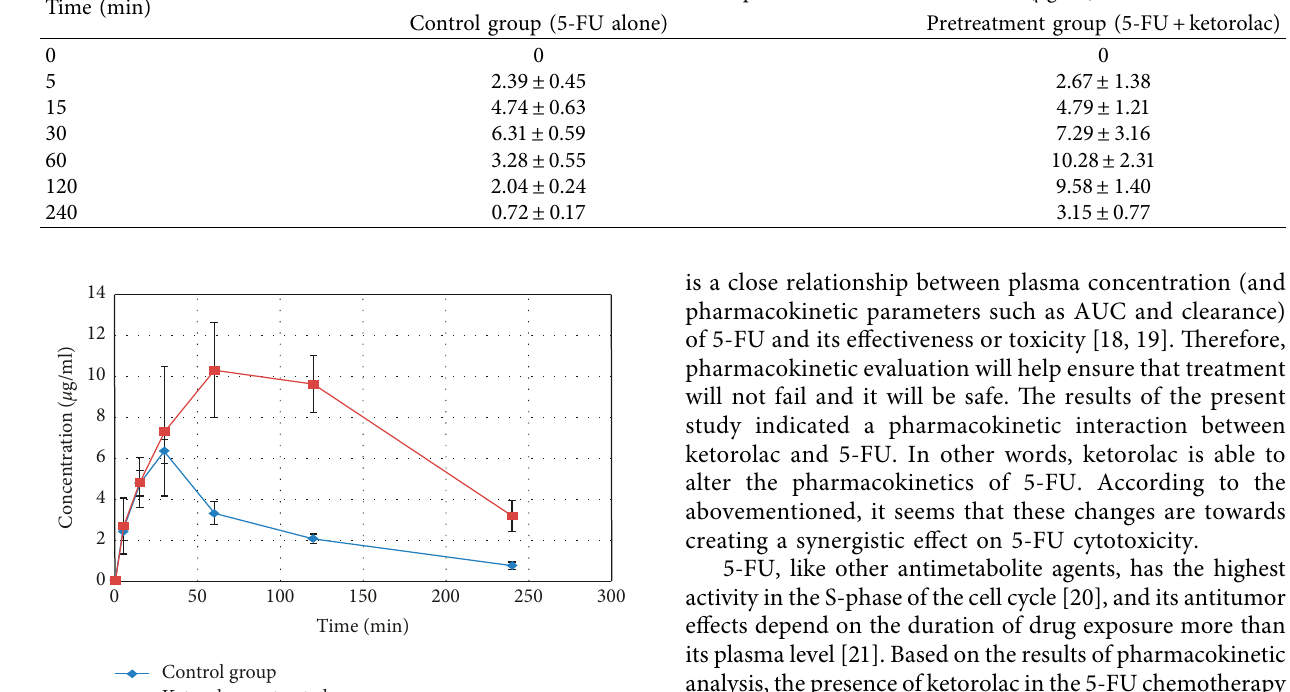
Figure 2: Comparison of HT-29 human colorectal cancer cell viability (%) after 48 hours of treatment with ketorolac, 5-FU, and combination of them at almost similar concentrations. Cell viability was determined by MTTassay and evaluated using a cell viability index (%), which was defined as: (mean absorbance in the test group/mean absorbance in the negative control group) × 100. Results are mean ± SD and significance level set at p ≤ 0 . 05. Table 1: Plasma concentration of 5-FU (50mg/kg, i.p) in the control group and the pretreatment group as mean ± SD ( p < 0 . 05). Mean ± STDEV plasma concentration of 5-FU ( µ g/ml) Time (min)